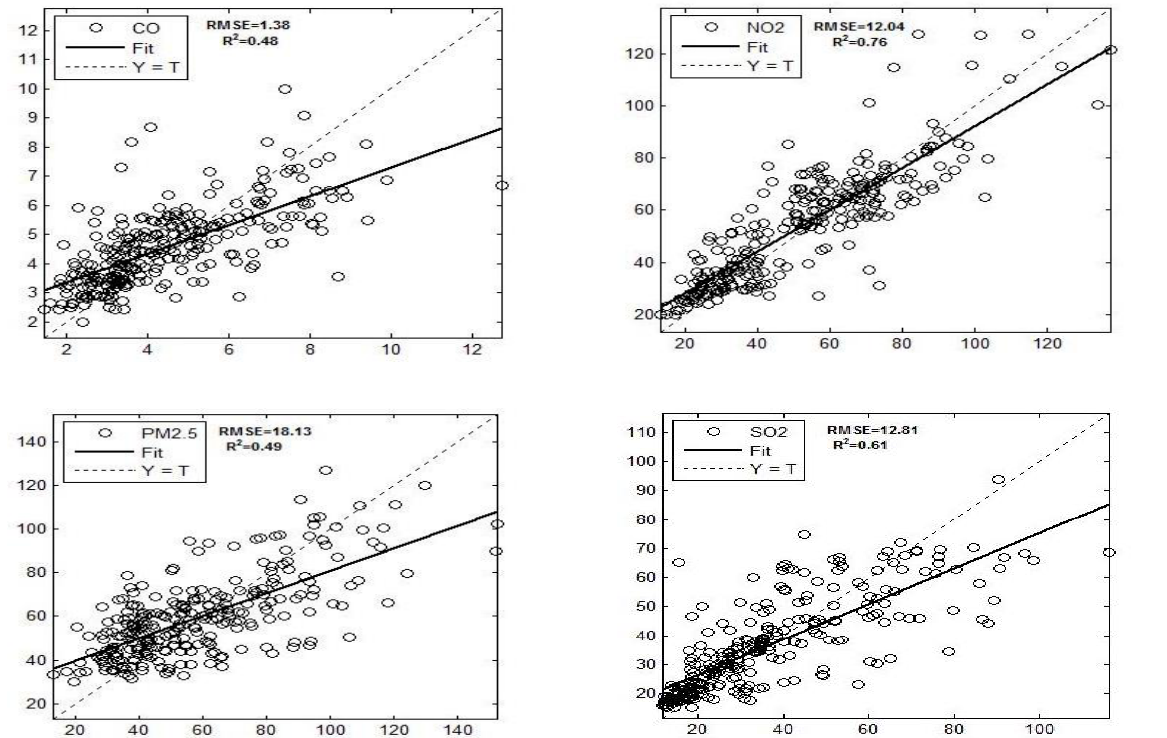
Figure1. Scatterplots of measured (horizontal axes) and predicted (vertical axes) air pollutants derived from the best prediction